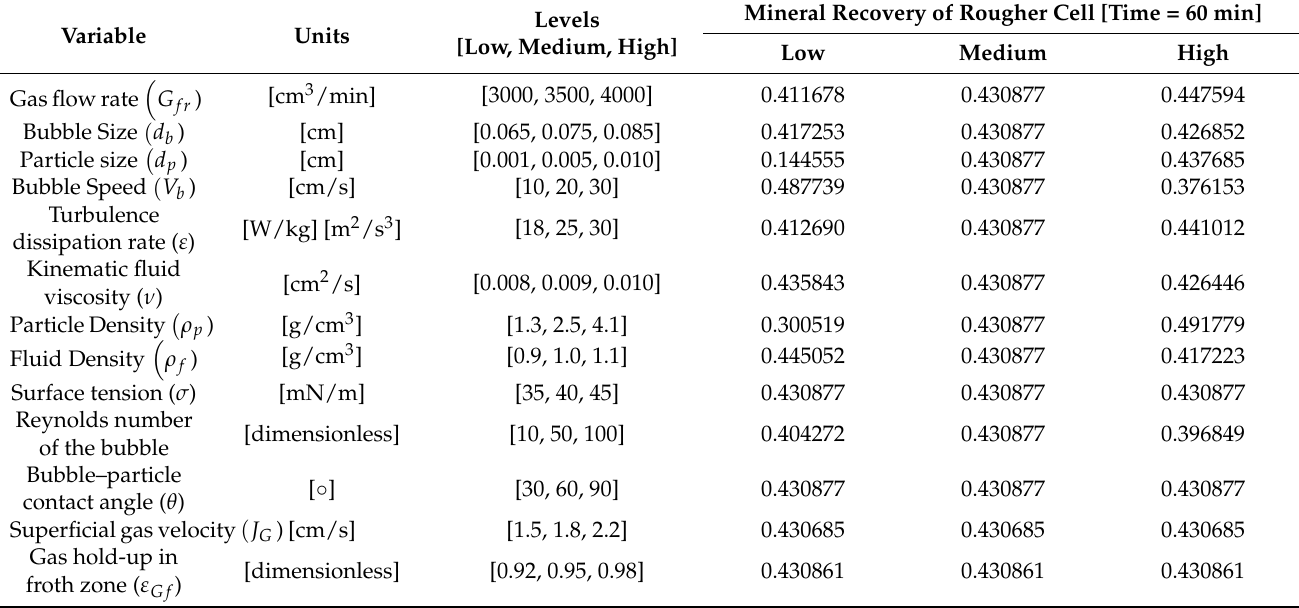
Table 2. Sensitivity analysis of mineral recovery for low, medium and high levels of the independent variables.